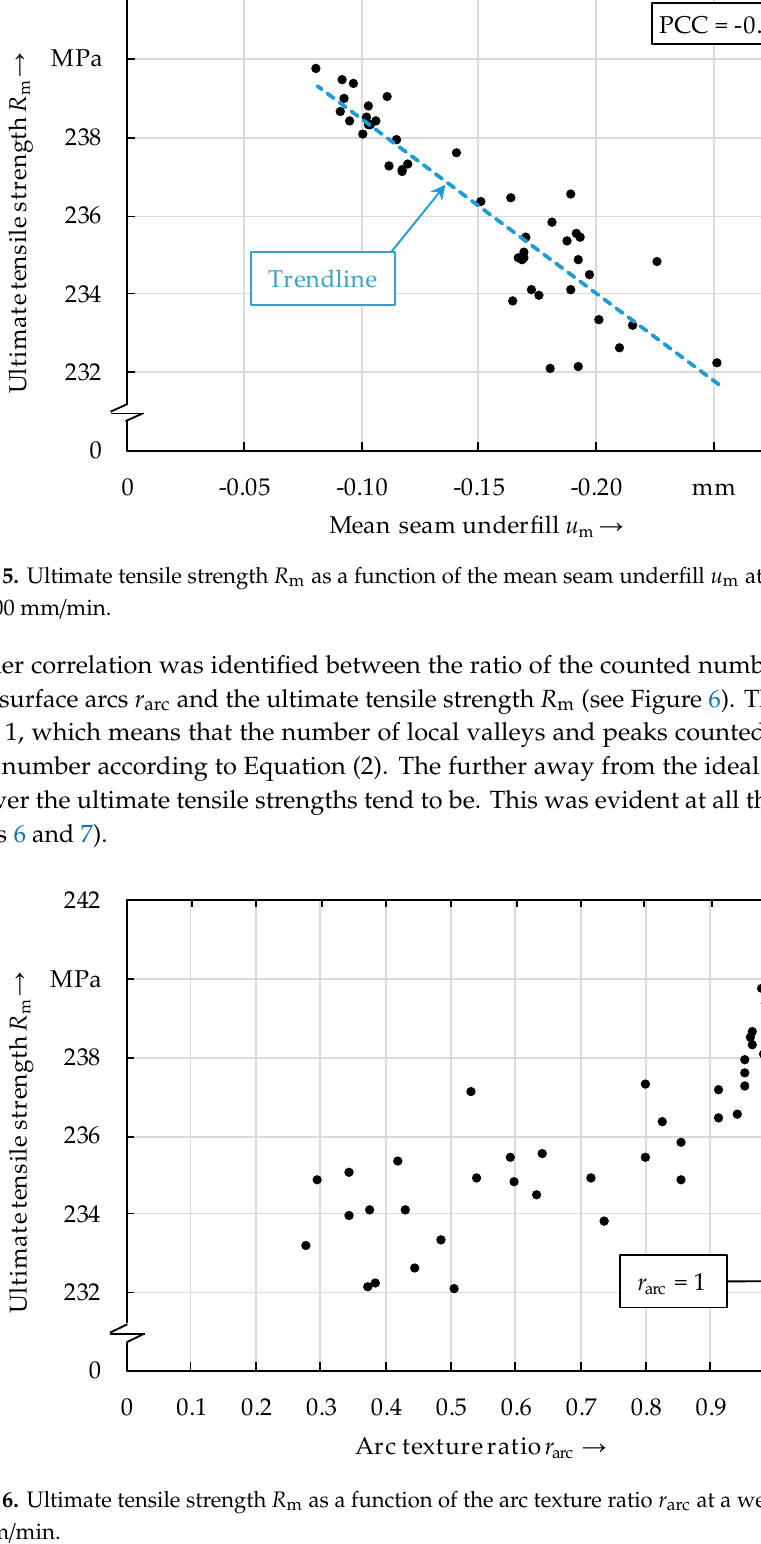
( b ) Figure 7. Ultimate tensile strength R m as a function of the arc texture ratio r arc ( a ) at a welding speed v s of 1000 mm/min and ( b ) at a welding speed v s of 1500 mm/min. Figure 7 also illustrates that an r arc ratio near 1 not only results in high ultimate tensile strengths, but that an r arc ratio of 1 can also lead to lower ultimate tensile strengths. Therefore, this was not yet a sufficient condition, but merely a necessary one to ensure a high ultimate tensile strength. For this reason, in the next step, the 15-mm-long weld sections on the surface of the tensile specimens (see Figure 2a) were divided into five 3-mm-long segments, and the ratio r arc of each segment was calculated. The standard deviation of the arc texture ratio r arc of the five sections (which was called